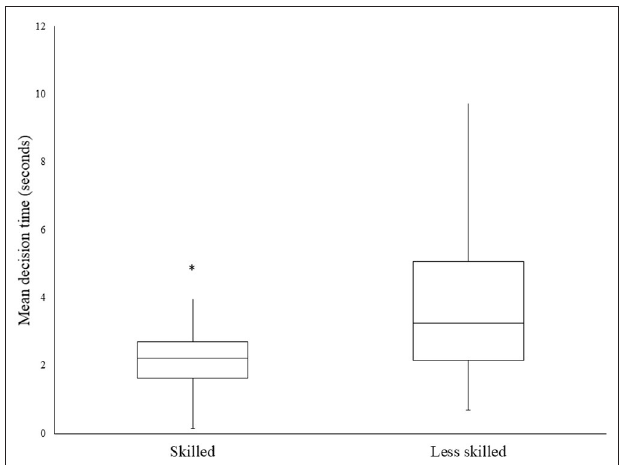
FIGURE 3 | Mean decision time between “skilled” and “less-skilled” participants. *Significantly different from less skilled p < 0.0001 (95% CI [0.302,